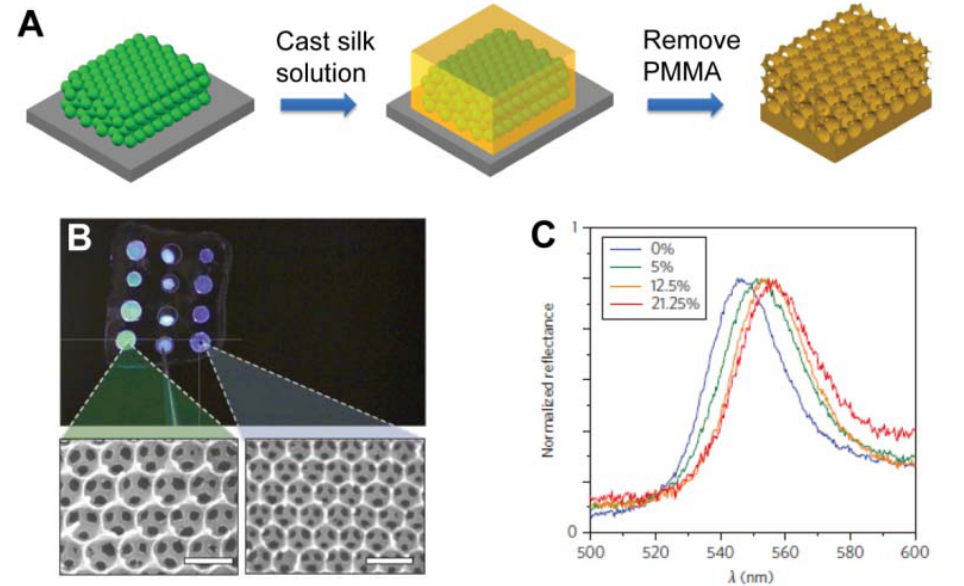
Figure 11. ( A ) Schematic illustration of fabrication steps for freestanding silk opal using a close-packed PMMA colloidal crystal as a template. ( B ) Photograph of a 2.5 × 1.5 cm freestanding silk film with patterned inverse opals. Corresponding SEM images show the green (left) and blue (right) silk opals. Scale bars, 500 nm. ( C ) Glucose refractive index sensing for the silk film with patterned inverse opals with lattice constants of 240 nm, showing reflectance spectra for different concentrations of glucose (0%, 5%, 12.5% and 21.25%)